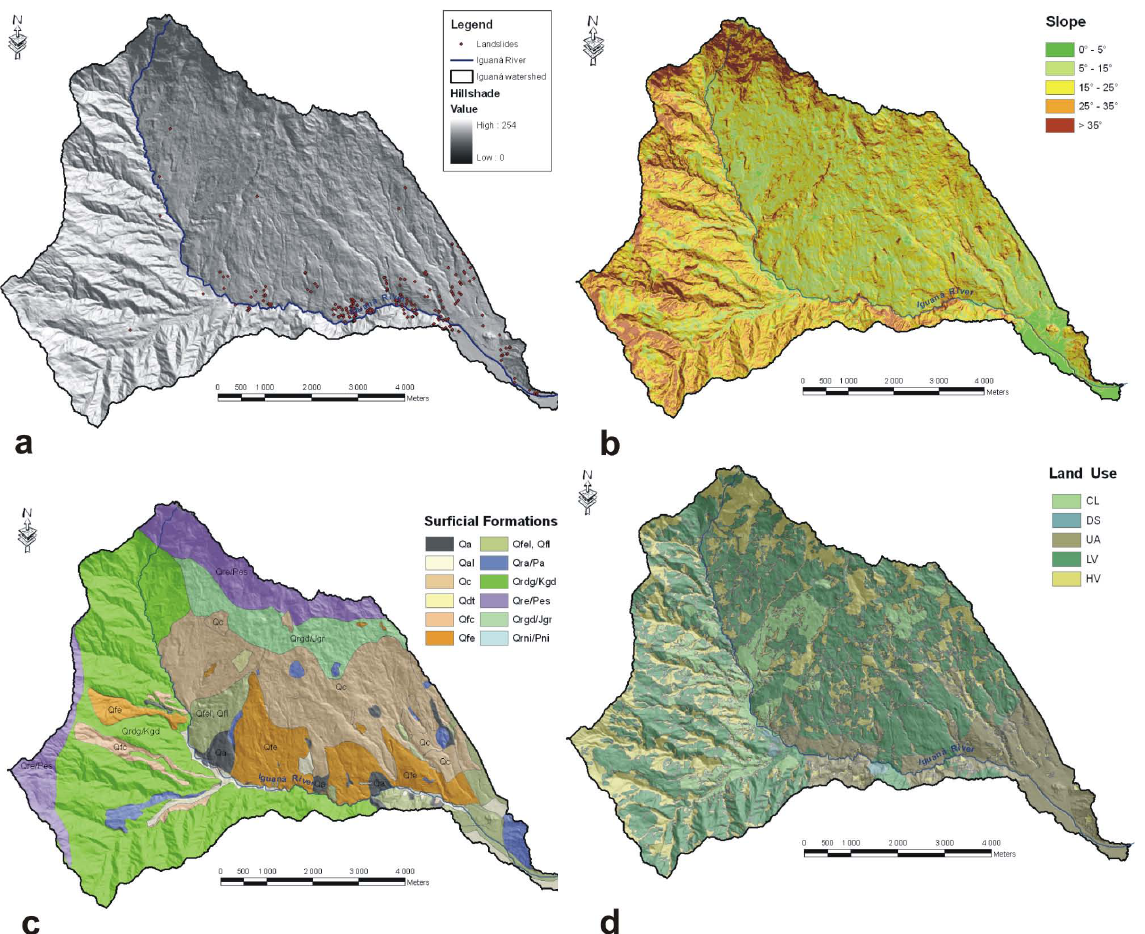
Fig. 3. Input data layers: (a) landslide map; (b) slope map; (c) superficial geology; (d) land use. For c: Qa – anthropogenic deposits; Qal – alluvial deposits; Qc – colluvial deposits; Qdt – detritus deposits; Qfc – consolidate